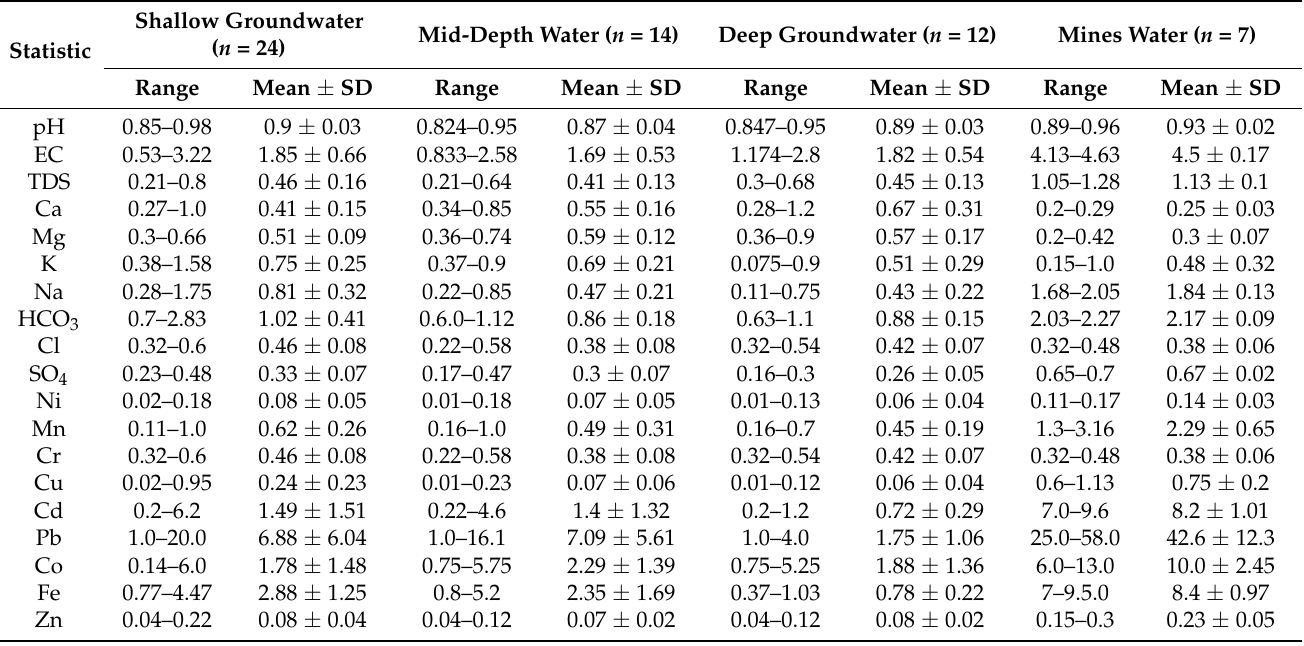
Table 5. Nemerow’s pollution indexing representing the water quality status of three hydrological environments in the groundwater system compared with mine